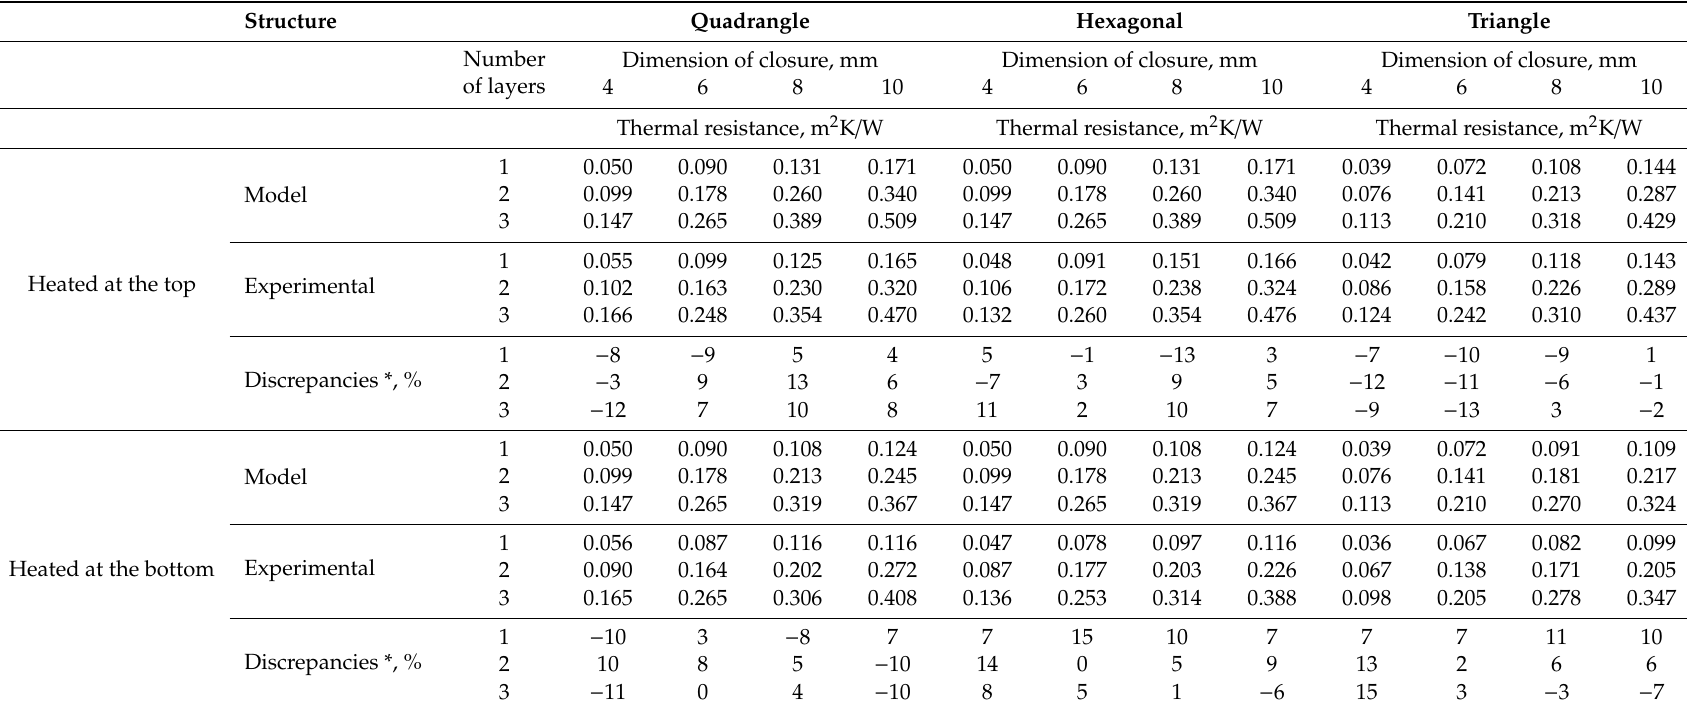
Table 1. Comparison of calculation and experimental results of the thermal resistance of the